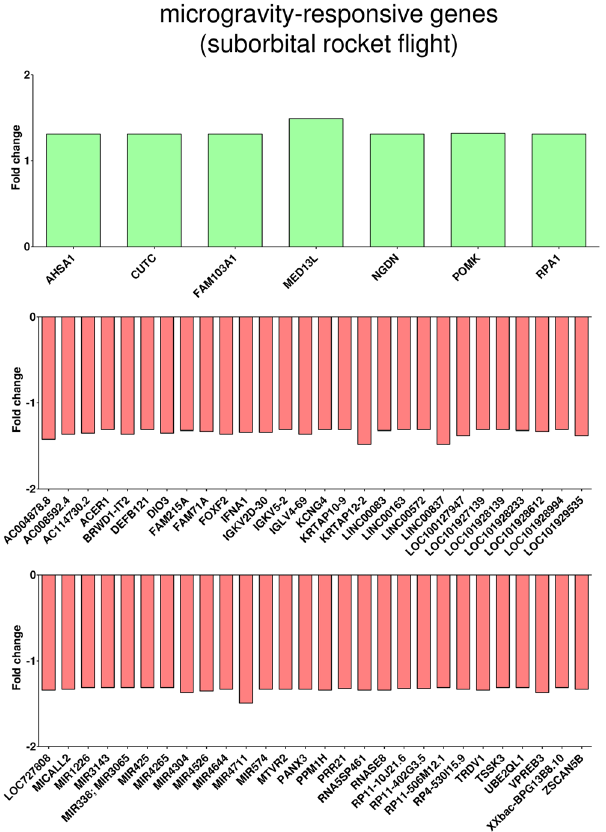
Figure 7. Microgravity-responsive gene expression (suborbital rocket flight). Exposure of Jurkat T cells to 5 min of microgravity during the TEXUS-51 suborbital rocket flight led to seven up and 56 down-regulated genes when compared to the 1 g in-flight control (log2 values, p <